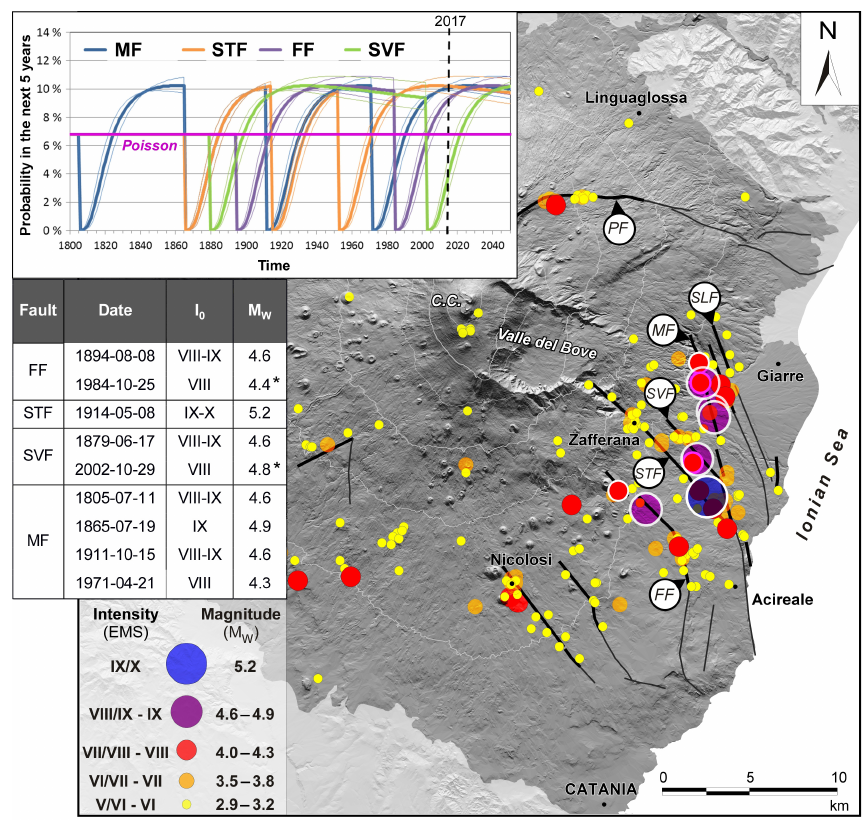
Figure 2. Distribution of the historical seismicity in the Etna region from 1600 to 2015 (data from CMTE Working Group, 2017). Major events considered for the analysis are outlined by a white circle and listed in the enclosed table (asterisk indicates an instrumental value); fault pattern and abbreviations as in Fig. 1; C.C. indicates the central craters. Inset map shows the retrospective test of the time-dependent model based on intertimes and b values of faults: colored curves indicate the variation in time of the conditional probability assigned to the faults of the SZ Timpe in the next 5 years. Before the first event assigned to each fault, the probability is assumed as Poissonian; following the earthquake, the probability curve collapses and progressively increases until the next rupture (from Azzaro et al.,